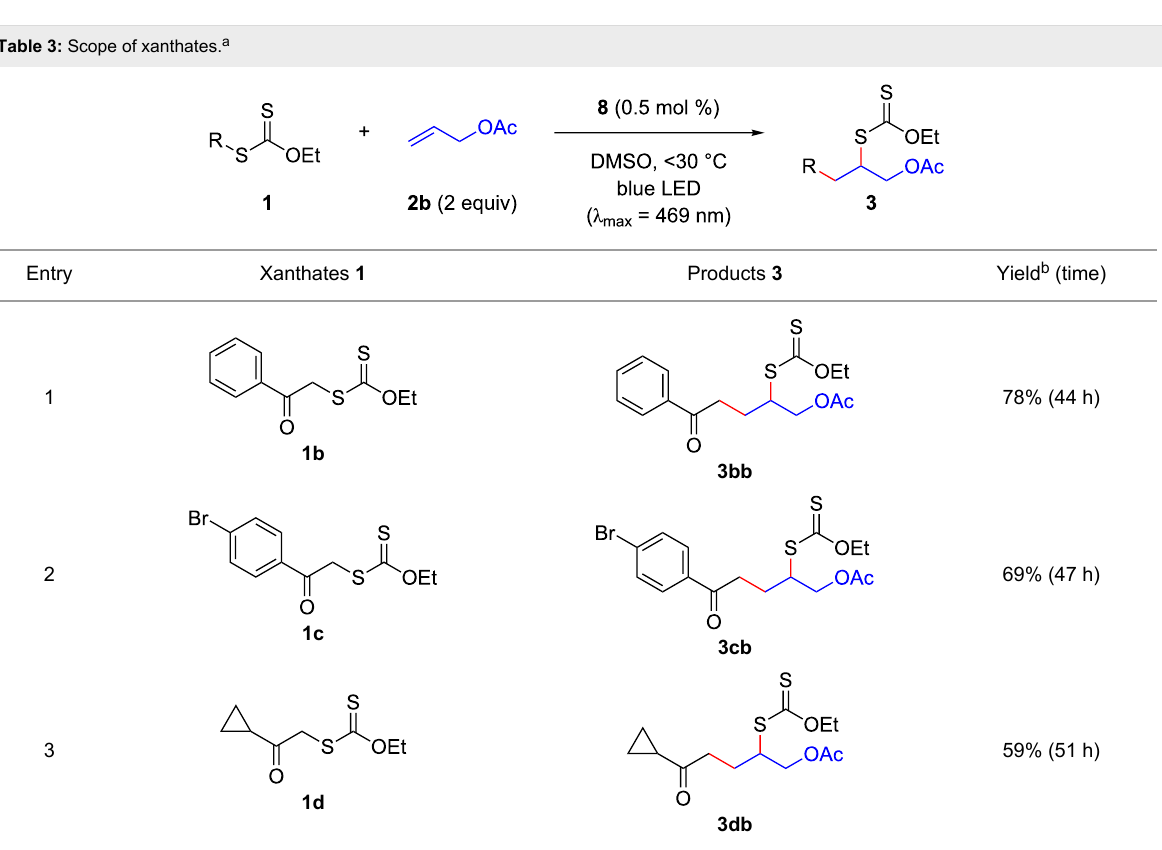
Table 3: Scope of xanthates.